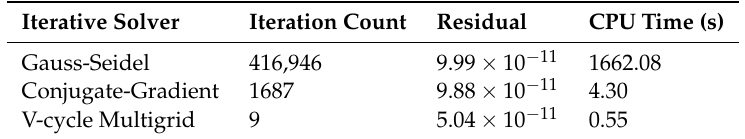
Table 2. Comparison of different iterative methods in terms of iteration count, residual and CPU time for solving the Poisson equation on a resolution of N x = 512 and N y =